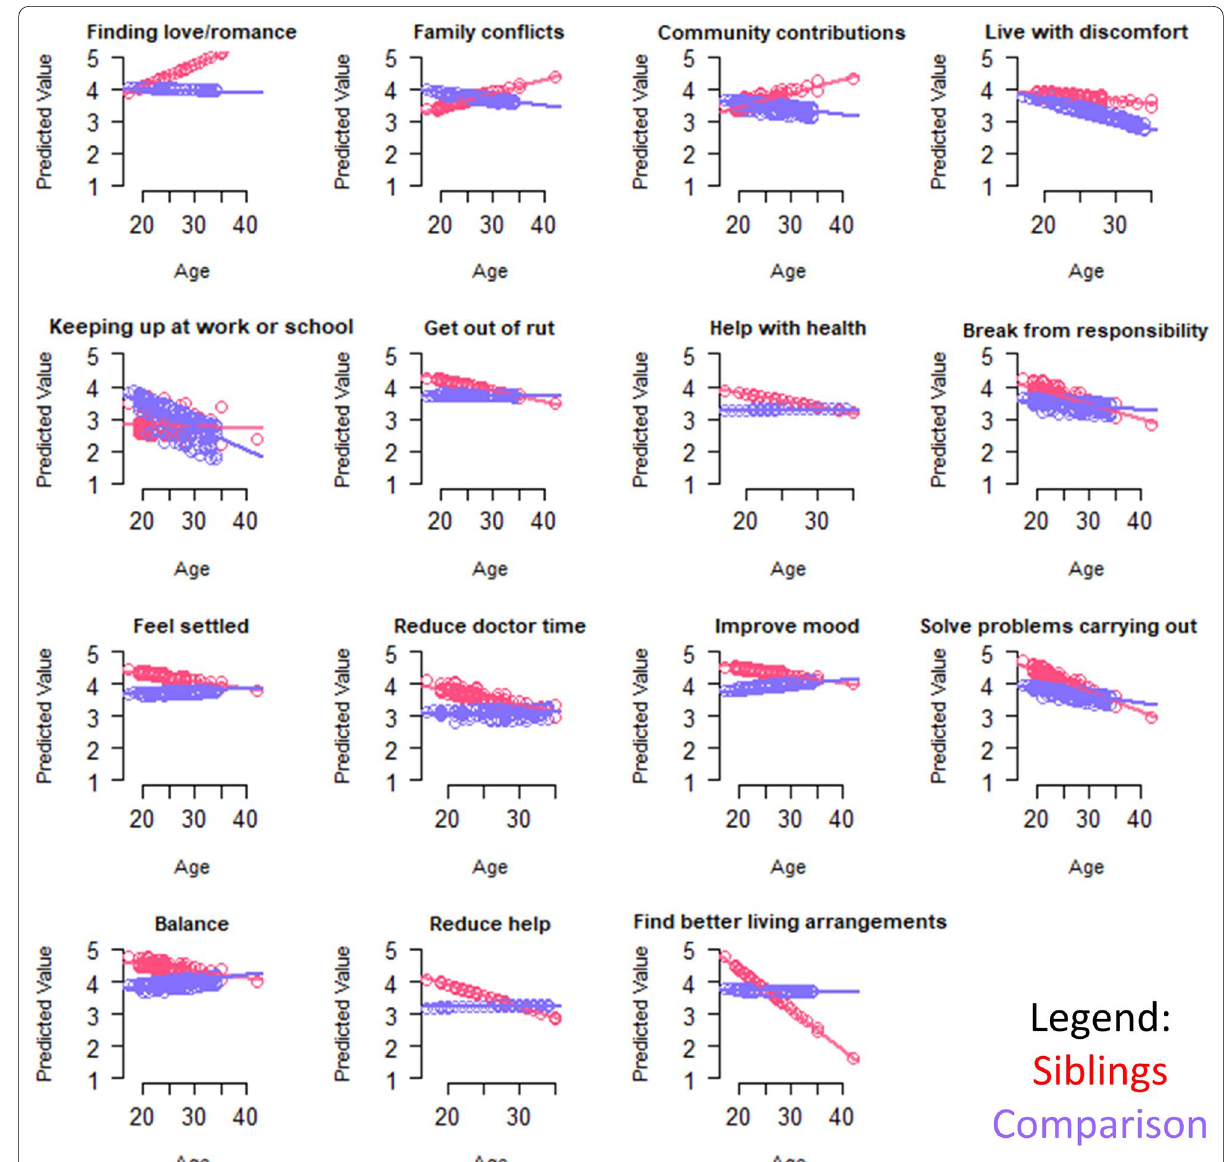
Fig. 5 Interaction plots for adjusted ANCOVA models predicting Goal items. Role-group differences for medium- and large-ES interaction effects are shown. Sibling predicted values are shown in red; comparison in